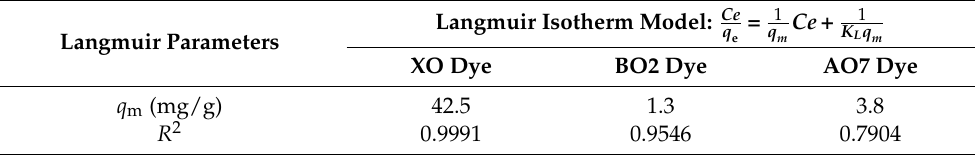
Figure 4. Langmuir linear fittings of ( a ) XO, ( b ) BO2, and ( c ) AO7 dyes adsorbed onto the superparamagnetic Fe 3 O 4 nanoparticles. Table 2. Relevant parameters of Langmuir fittings for XO, BO2, and AO7 dyes adsorbed onto the superparamagnetic Fe 3 O 4 powders.